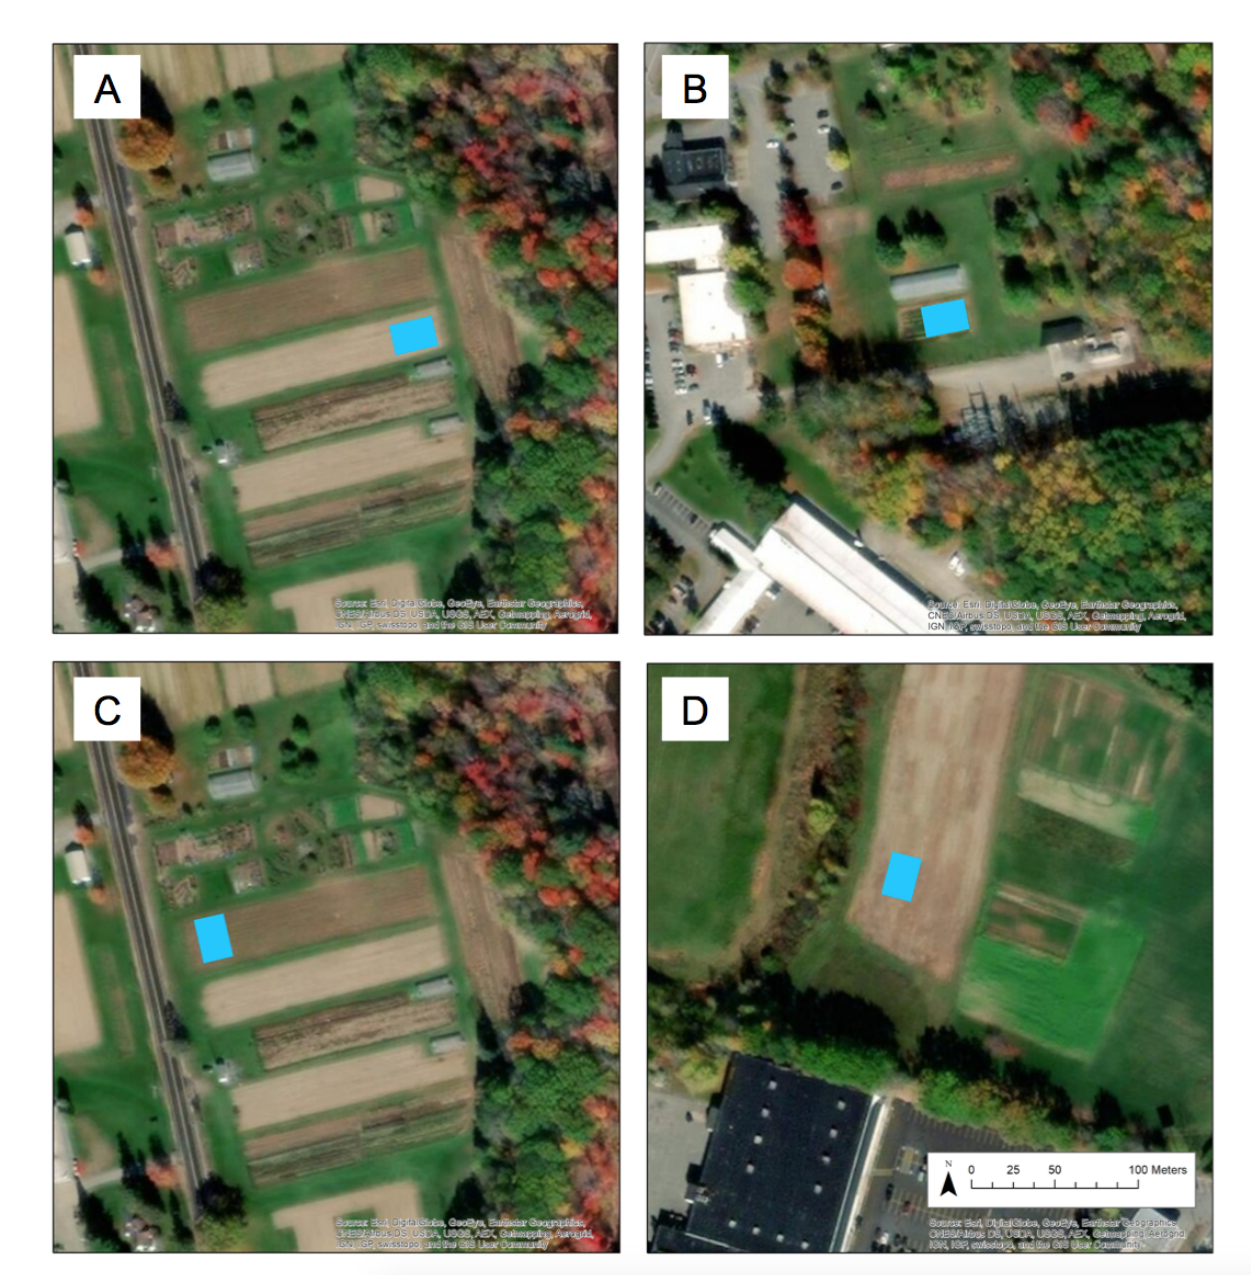
Figure A1. Aerial view showing locations of four spring solarization experiments: (A) Rogers 2015, (B) UMG 2015, (C) Rogers 2016, and (D) Smith